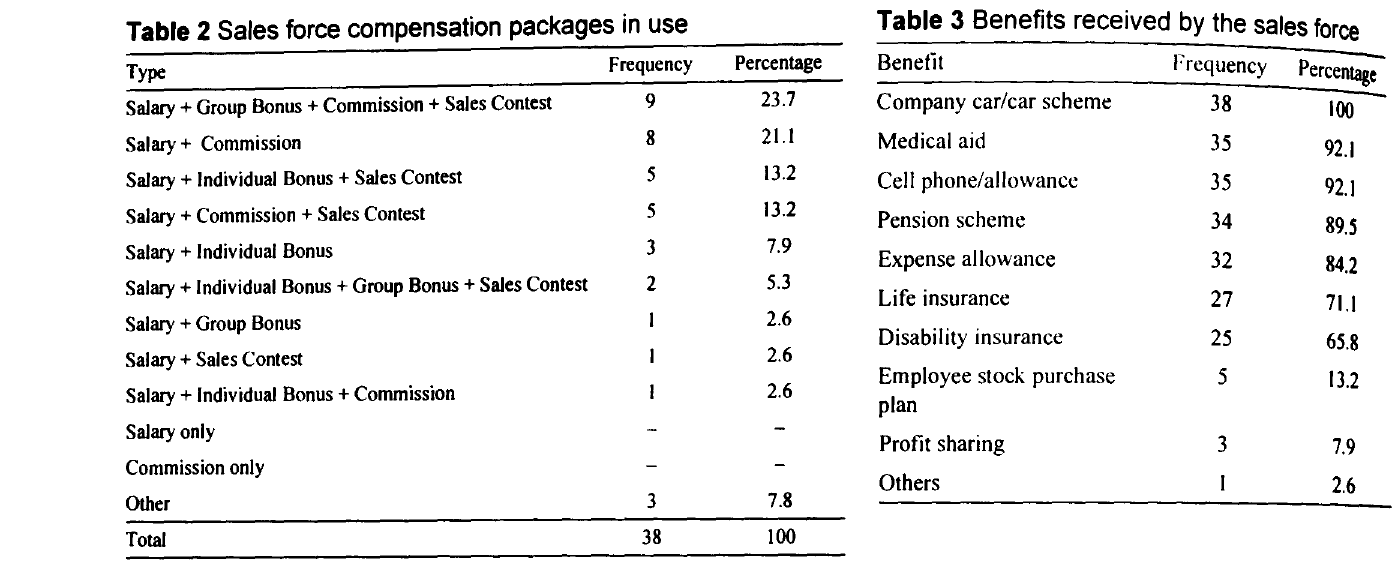
Table 2 Sales force compensation packages in use Table 3 Benefits received by the sales